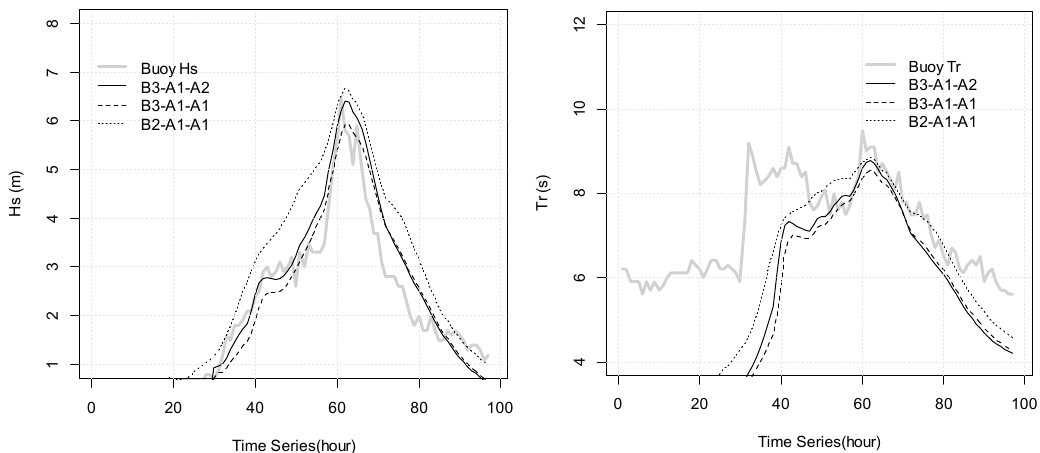
Figure A1. Comparison of typhoon waves induced by Typhoon Chanthu (03-2010) at buoy QF303: the standard H10 is indexed as B2-A1-A1, the model with varying parameter b without an asymmetric typhoon structure is indexed as B3-A1-A1, and MH10 is indexed as B3-A1-A2.